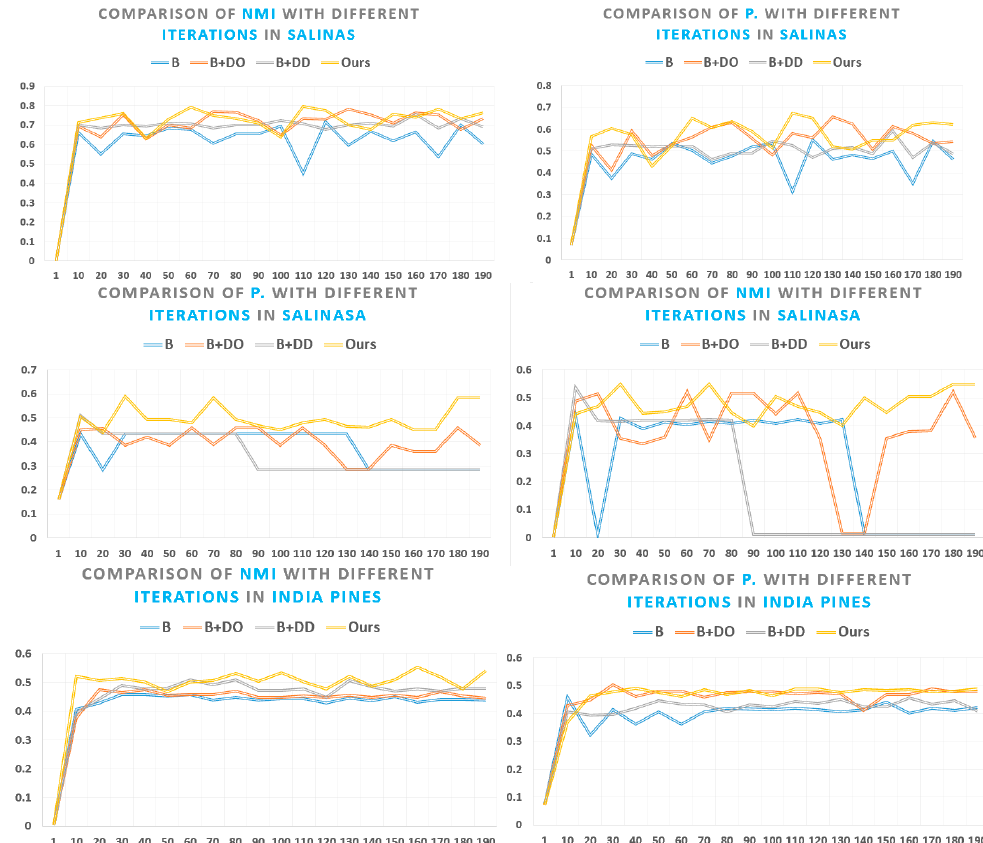
Figure 5. Classification results in different numbers of iterations.